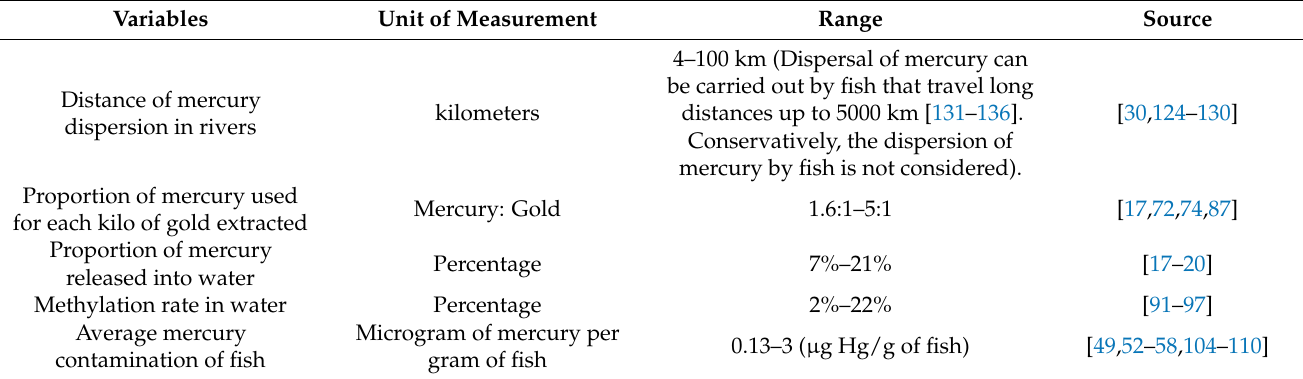
Table 1. Summary of variables, unit of measurement, range values, and source used in this article. Variables Unit of Measurement Range Source